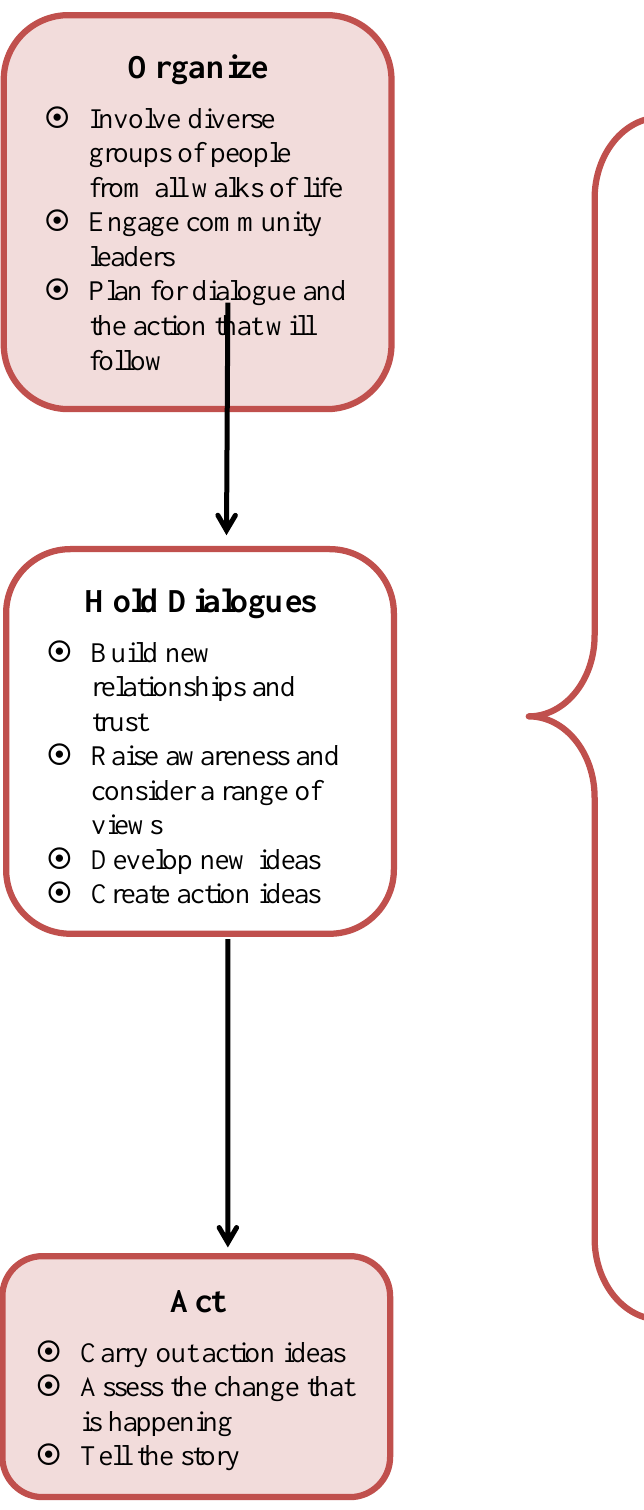
Figure 2. Overview of Facing Racism in a Diverse